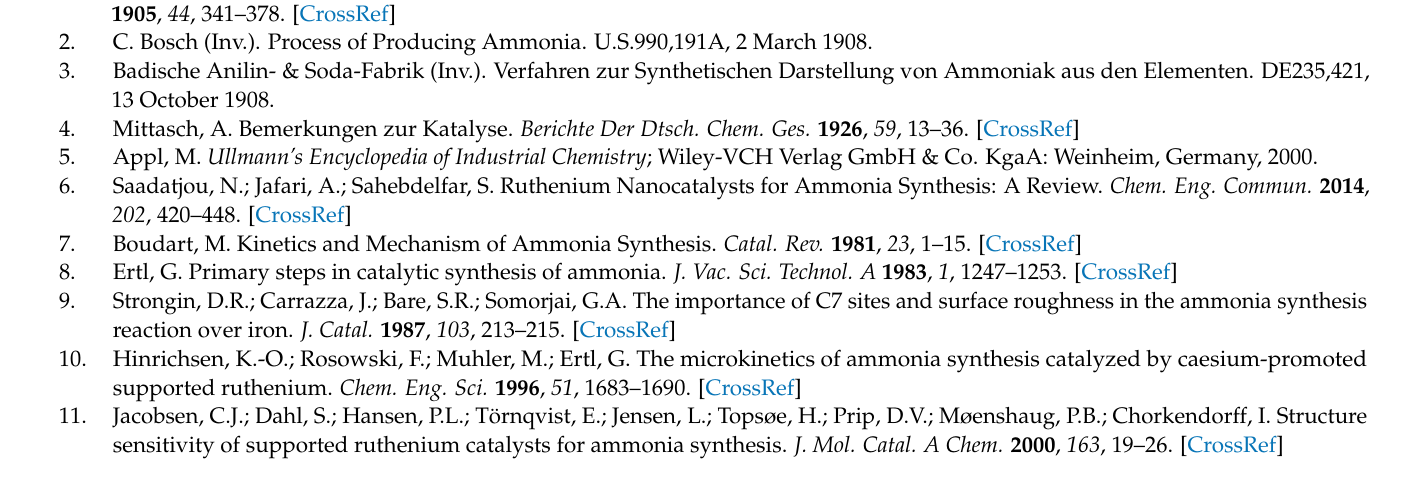
Figure S2. PXRD after Ru deposition on plasma synthesized C12A7e − (3C) (red) and C12A7 (blue) samples. Figure S2. Rietveld refinement of the crystal structure of mayenite electride (vacuum sintering-based C12A7e − (e) sample. Figure S3. Rietveld refinement of the crystal structure of the deuteride of mayenite electride (C12A7:D (k)